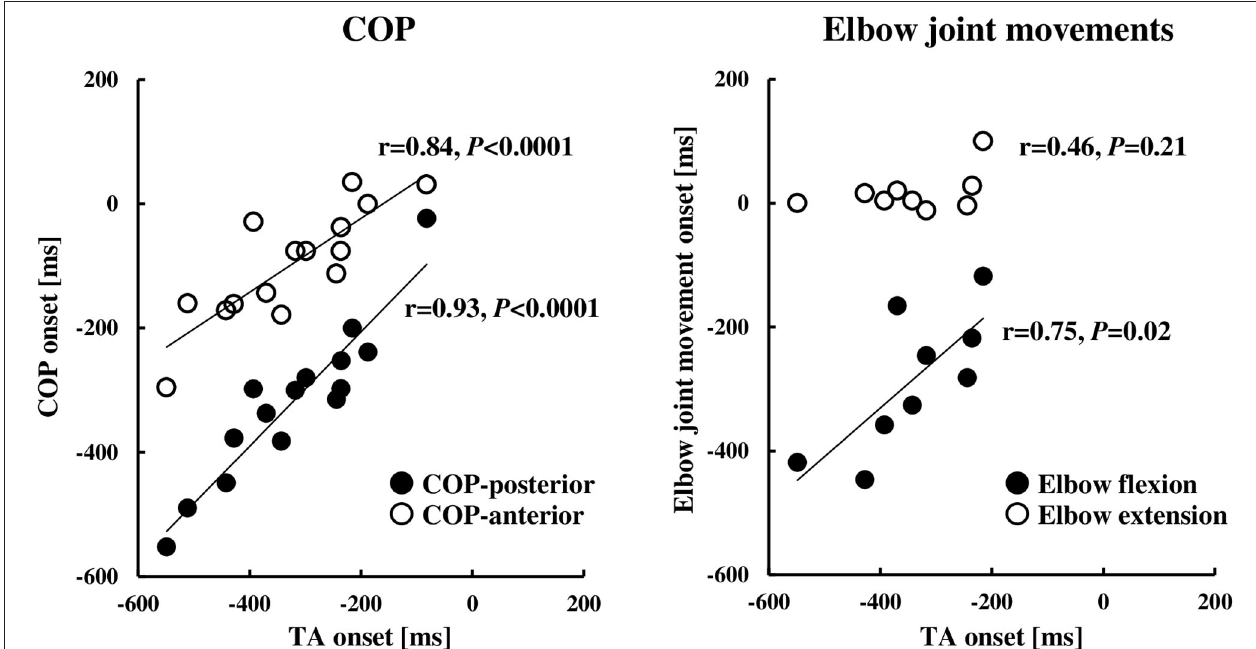
FIGURE 3 | Relationships between the onset of the TA muscle and COP ( n = 15) or elbow joint movement ( n = 9). The onset timings were calculated by the onset of the TB muscle (0ms, the TB onset). COP, the center of pressure; TA, tibialis anterior; TB, triceps